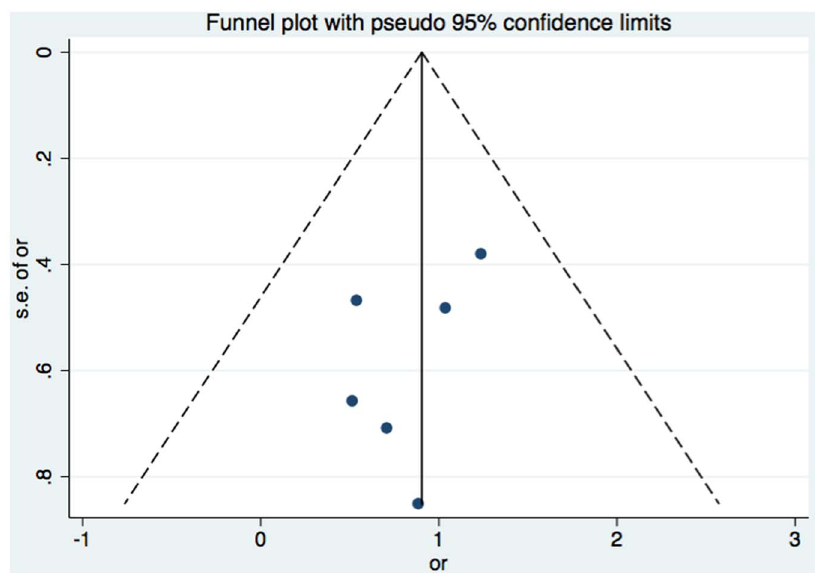
Figure 3. Funnel plot of publication bias for total complication.